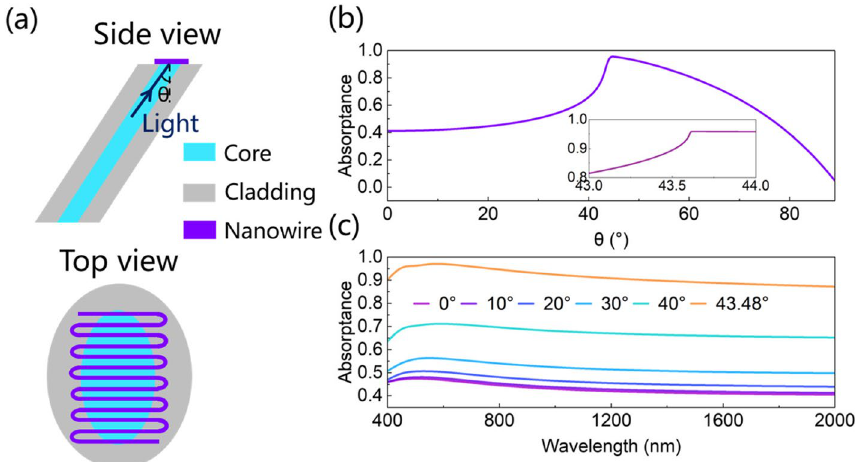
Fig. 5 a Schematic of FSPD with incident photons at angle θ . b At 1550 nm wavelength, absorptance as a function of the incident angle θ from 0° to 89°. Inset: magnified view with incident angles ranging from 43° to 44°. c Simulated absorptance of nanowires as a function of the incident photon wavelength with θ at 0°, 10°, 20°, 30°, 40°, and